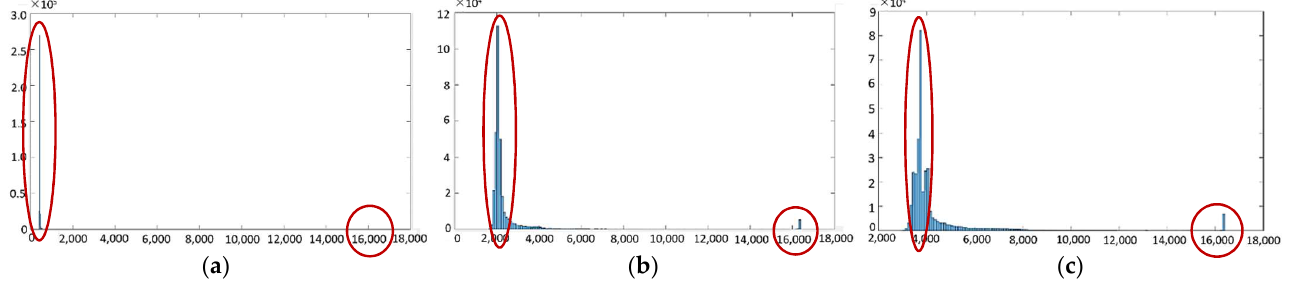
Figure 4. Histogram of the grayscale distribution of single-integration time-based IR images: ( a ) 13